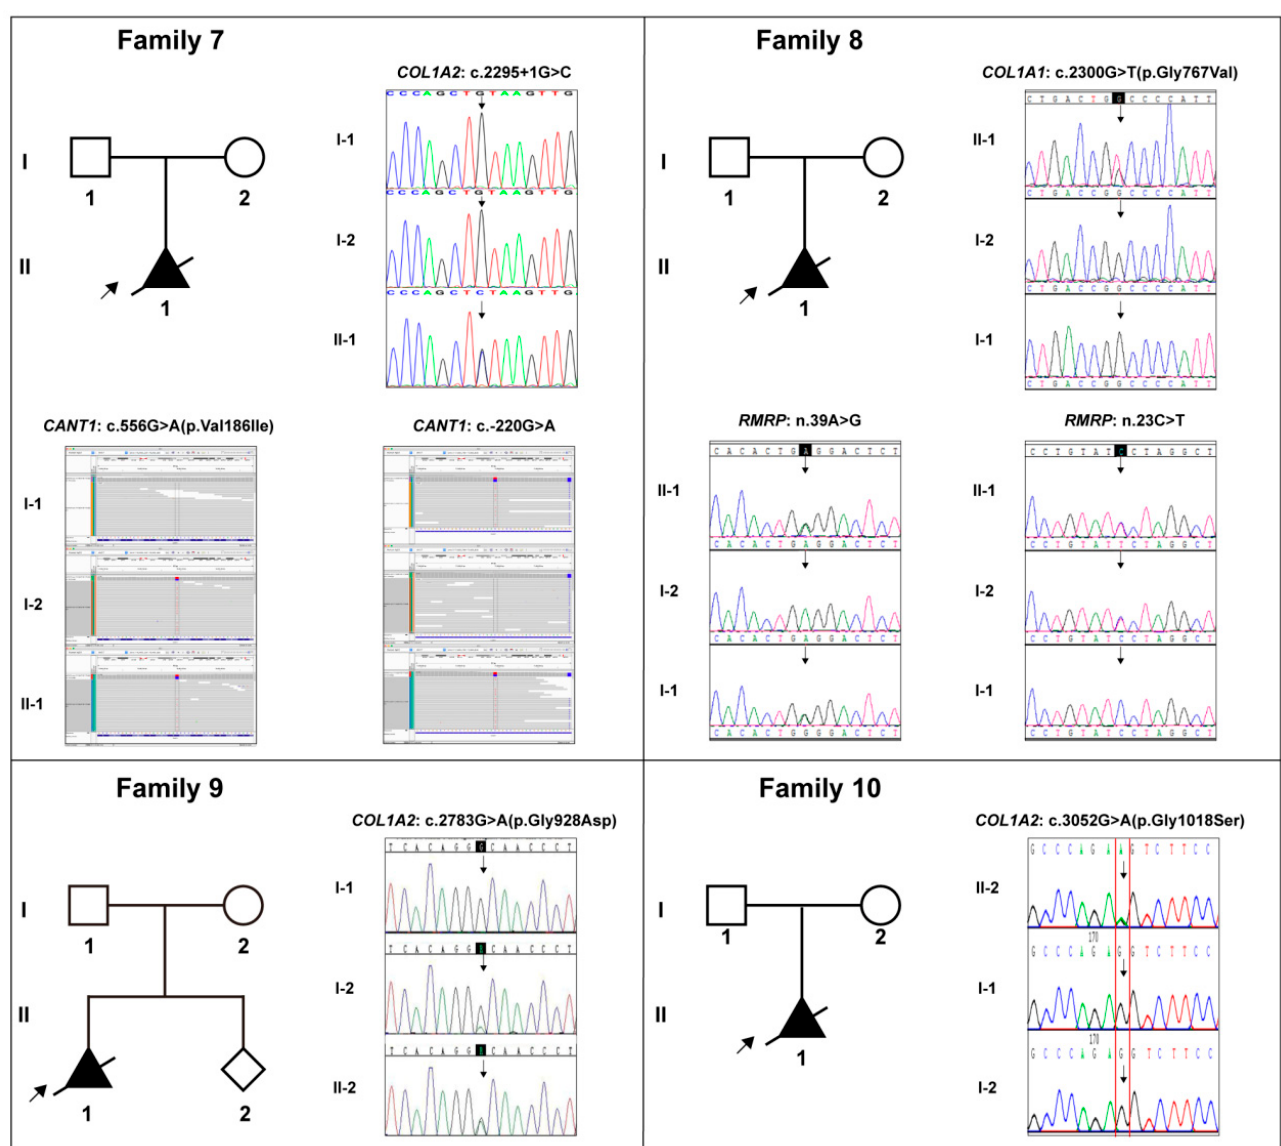
Figure 3. The pedigree diagrams of Cases 7–10 (Families 7–10) and the variants in collagen genes ( COL1A1/2 ), CANT1 gene, and RMRP gene in Sanger sequencing or Bam form, and their corresponding carrying status in each family. Note: Solid shapes represent mutation carriers; the arrow points to the probands; the diagonal line means dead.